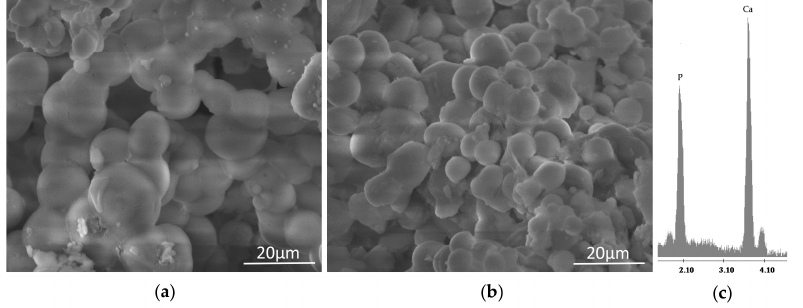
Figure 5. SEM micrographs of ( a ) pure SiO 2 and ( b ) a representative SiO 2 /CGA hybrid; and ( c ) EDX